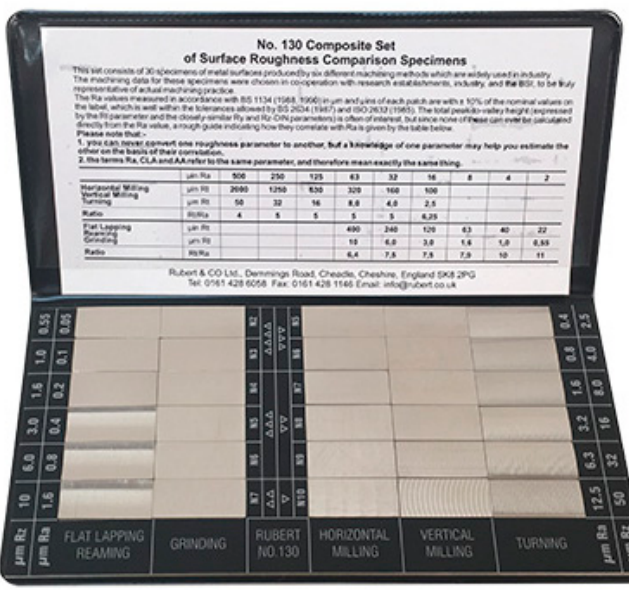
Figure 3. Commercial Roughness Comparison Specimens [39].